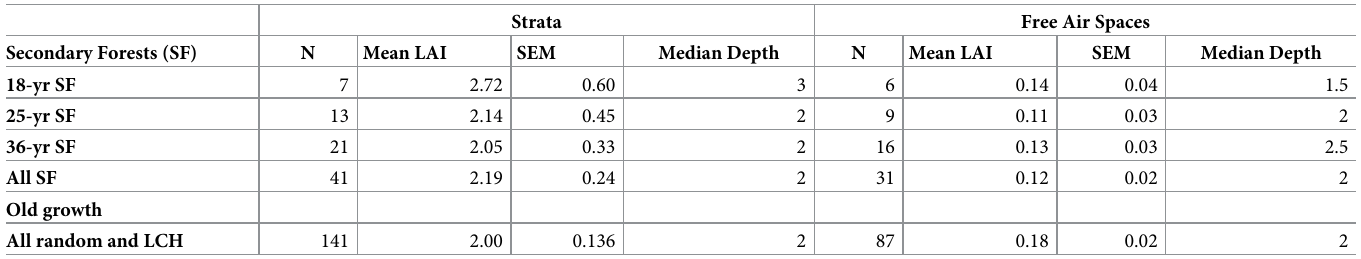
Definitions of strata and free spaces are given in Methods . Strata and Free Air Space depths were quantified as the number of canopy tower sections (each 1.86 m tall) occupied. Old-growth data [35] include all 45 randomly-selected sites and 10 sites selected for canopy heights < 16 m (Low Canopy Heights LCH). SEM =